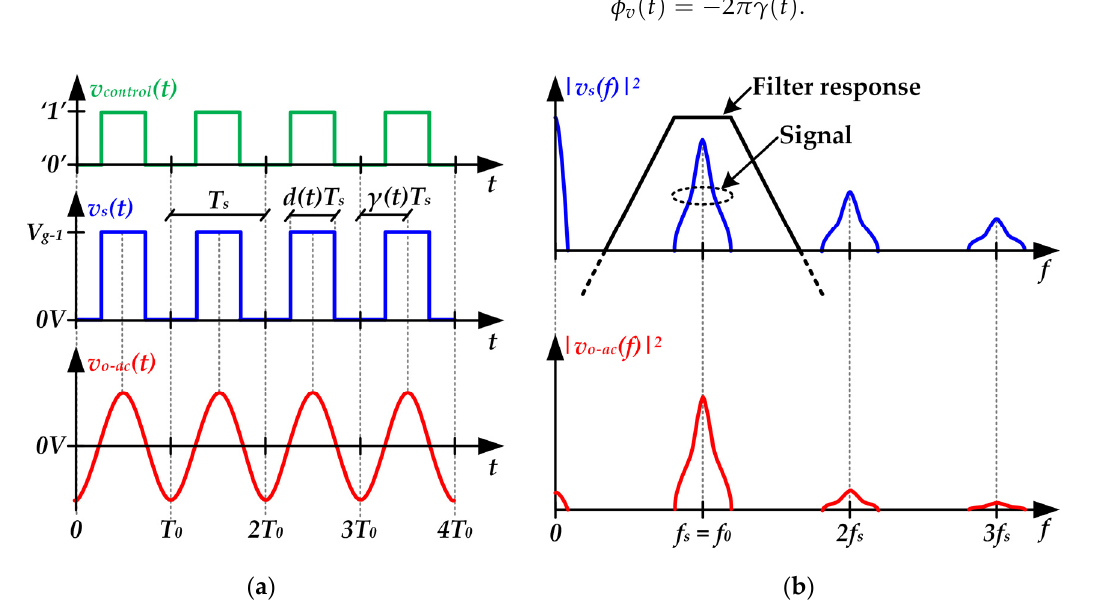
Figure 5. Main voltage waveforms of a RF-PWM Class D SMPA under steady-state conditions [i.e., considering fixed values of d ( t ) and γ ( t )]: ( a ) Time domain. ( b ) Frequency domain.